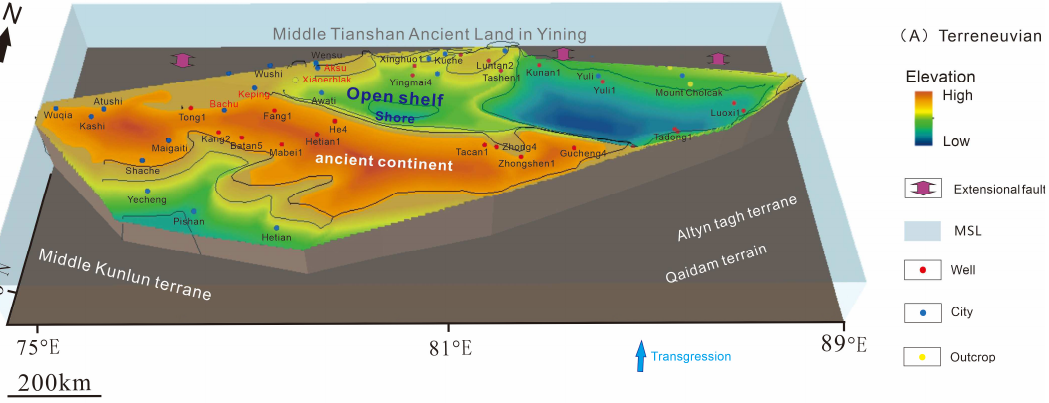
Figure 3. Sedimentary paleogeomorphic characteristics of Cambrian terreneuvian in the Tarim Basin [26,27,29–31,35,38,43,44,47–51].